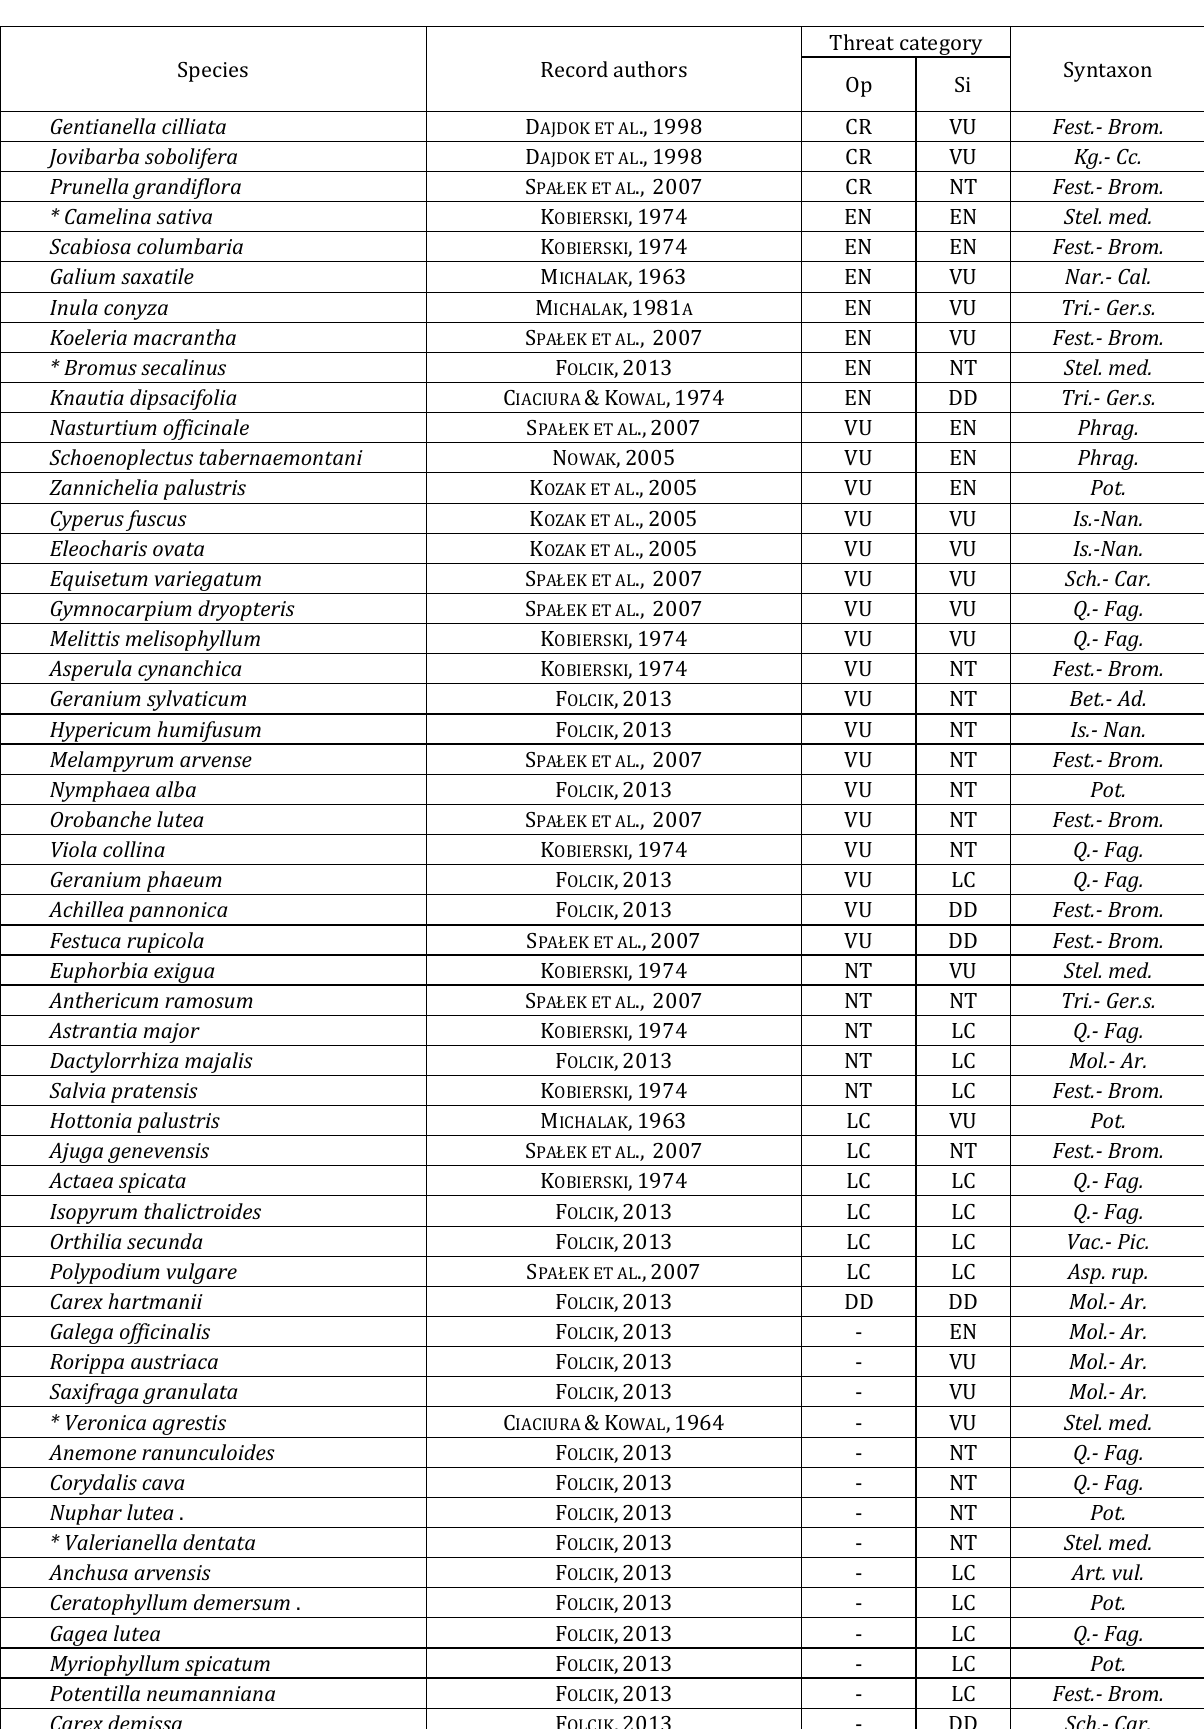
Table 2. Species confirmed after 1945 in Strzelce Opolskie (see abbreviation key for Table